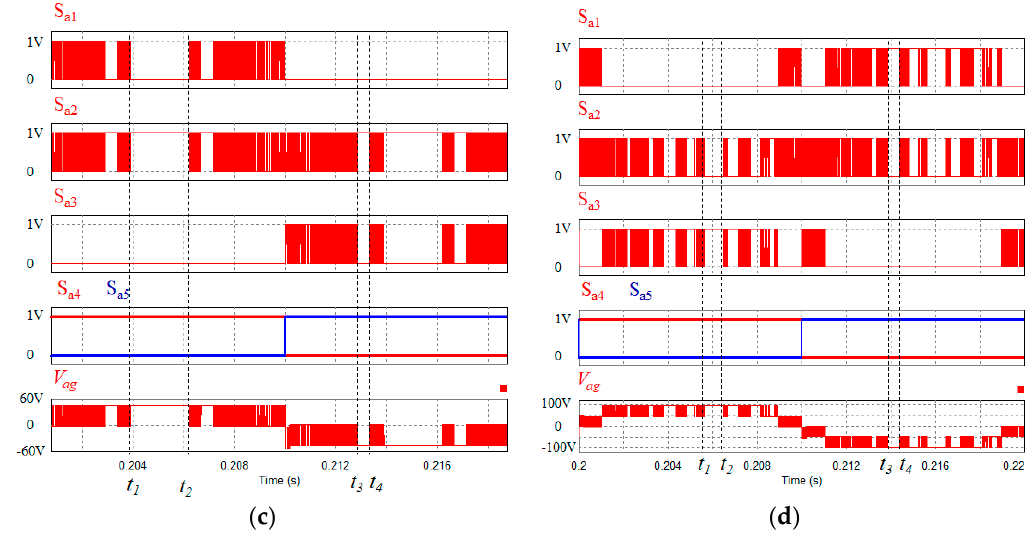
Figure 4. Control voltage generation, gating signals of S a1 to S a5 and the phase pole voltage in the proposed technique with ( a , c ) m = 0.4 and ( b , d ) m = 0.9.